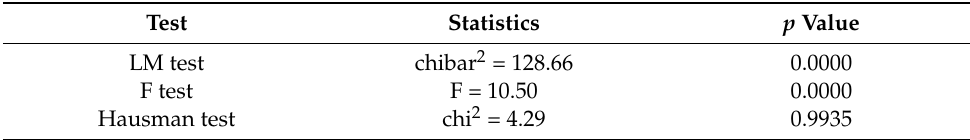
Table 4. LM test, F test and Hausman test